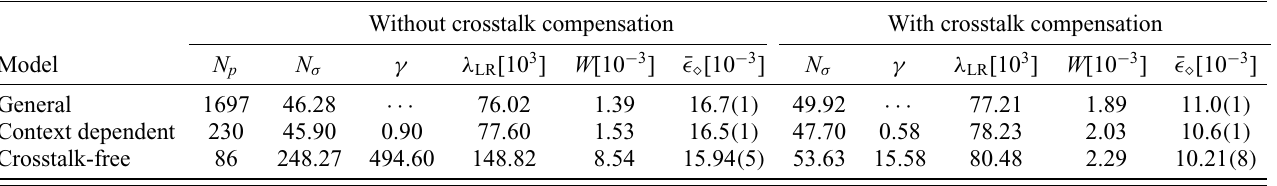
TABLE II. Fit quality metrics for three models on the AQT device. We tabulate metrics of fit quality and unmodeled error for three distinct models when fit to GST data from the AQT platform (both with and without crosstalk compensation). The performance of these models can be compared in detail using the log-likelihood ratio score λ LR , the N σ of model violation, and the residual wildcard error W . Each of these models further predicts an average diamond error ¯ (cid:10) (cid:13) for the gate set. Without crosstalk compensation, the context-dependent model is strongly preferred over the crosstalk-free model by the evidence ratio test γ , and the wildcard error is significantly reduced by moving to the larger model. The full Markovian model, however, requires nearly an order of magnitude more parameters, achieves only a small improvement in the likelihood ratio and the wildcard, and is rejected by the evidence ratio test. When crosstalk compensation is applied, the context-dependent model is again preferred by the evidence ratio test, but much more weakly, and the wildcard error is nearly constant across models. Crosstalk compensation further results in a (cid:15) 35% reduction in the average gate